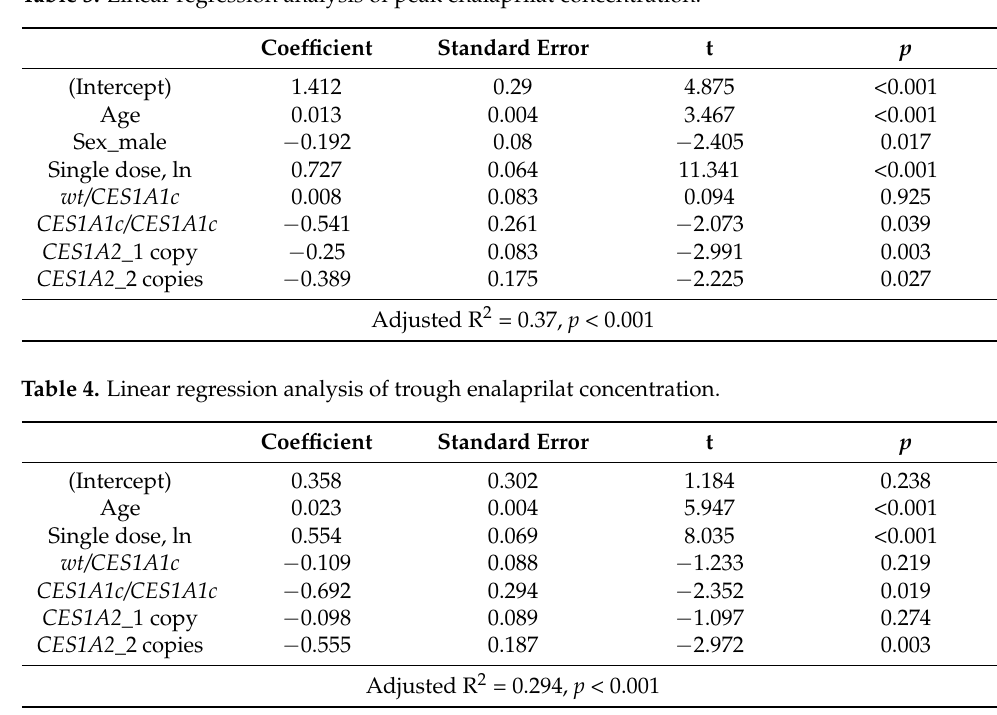
Table 3. Linear regression analysis of peak enalaprilat concentration.